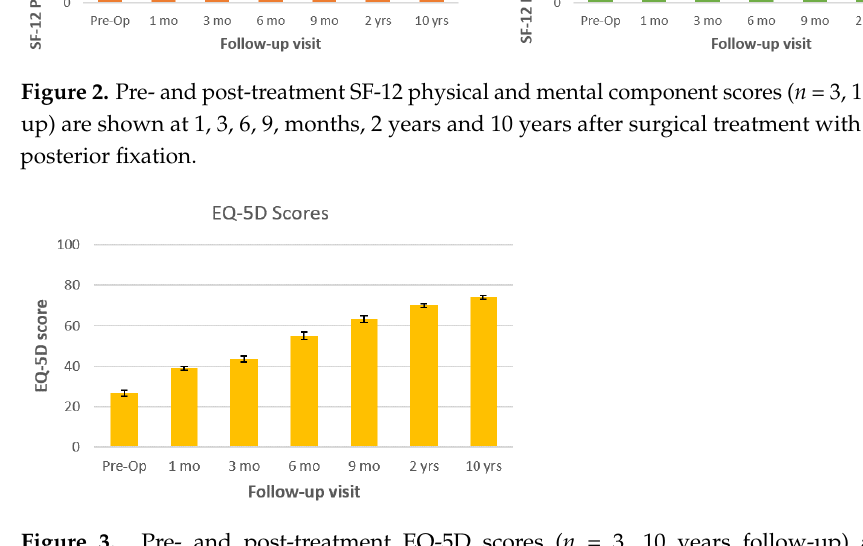
Figure 3. Pre- and post-treatment EQ-5D scores ( n = 3, 10 years follow-up) are shown at 1, 3, 6, 9, months, 2 years and 10 years after surgical treatment with percutaneous posterior fixation. Average pre-operative segmental kyphosis was 20.2° (15.9–22.4). Immediately after surgery segmental kyphosis was 17.0° (13.6–21.4), which was maintained at 15° (11.3–20.4)